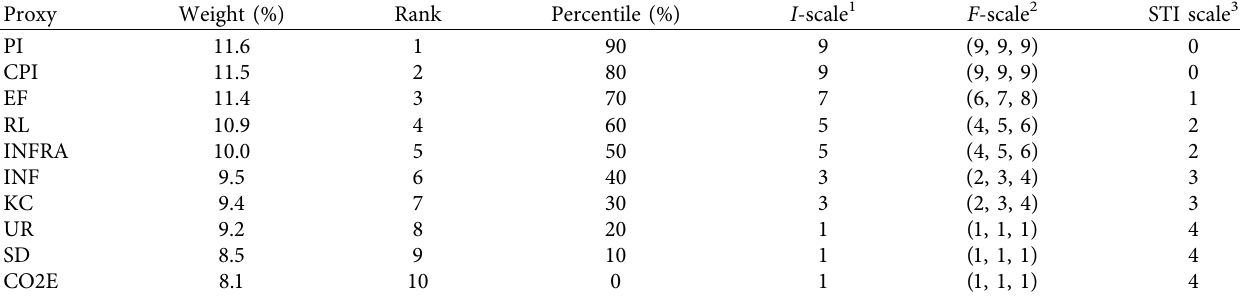
Table 8: Triangular fuzzy scale of relative